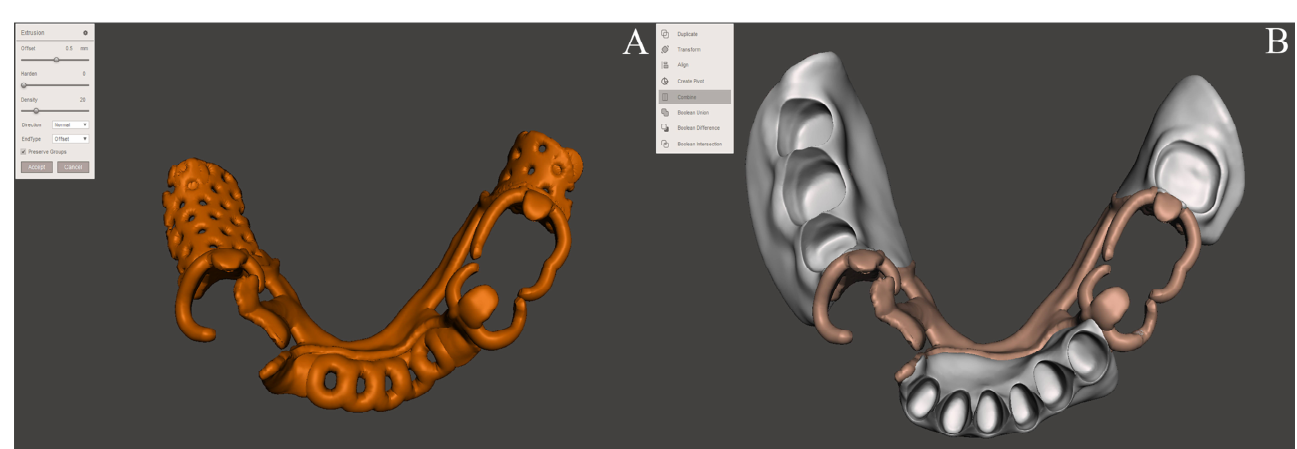
Figure 3. Virtual design of the denture base and offset metal framework complex. ( A ) Offsetting metal framework. ( B ) Combining the denture base and offset metal framework.